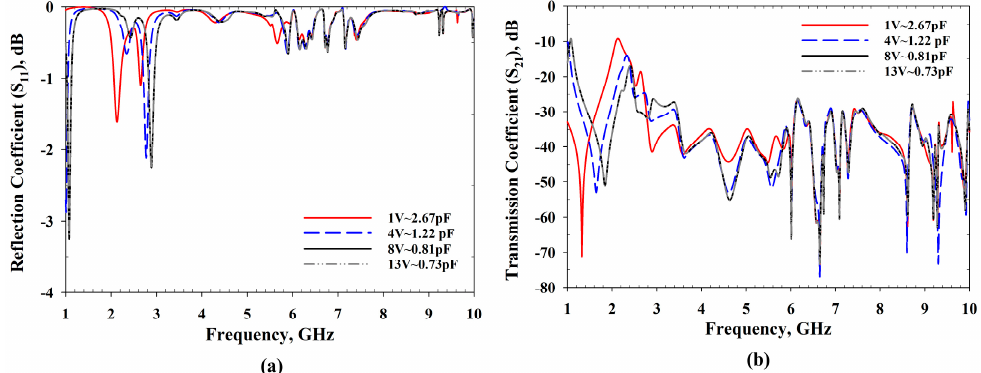
Figure 6. Effect of varactors tuning over MTM features: ( a ) S 11 and ( b ) S 21 .